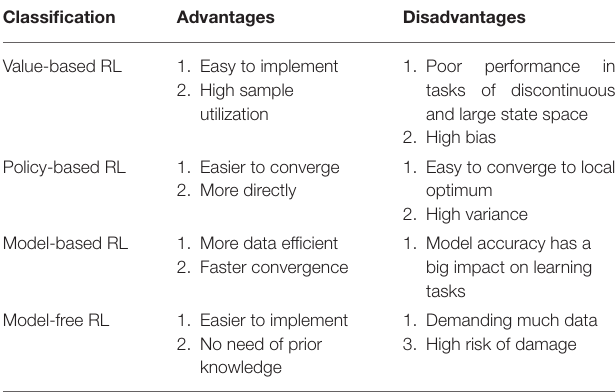
TABLE 2 | Classification and corresponding advantages and disadvantages of the RL